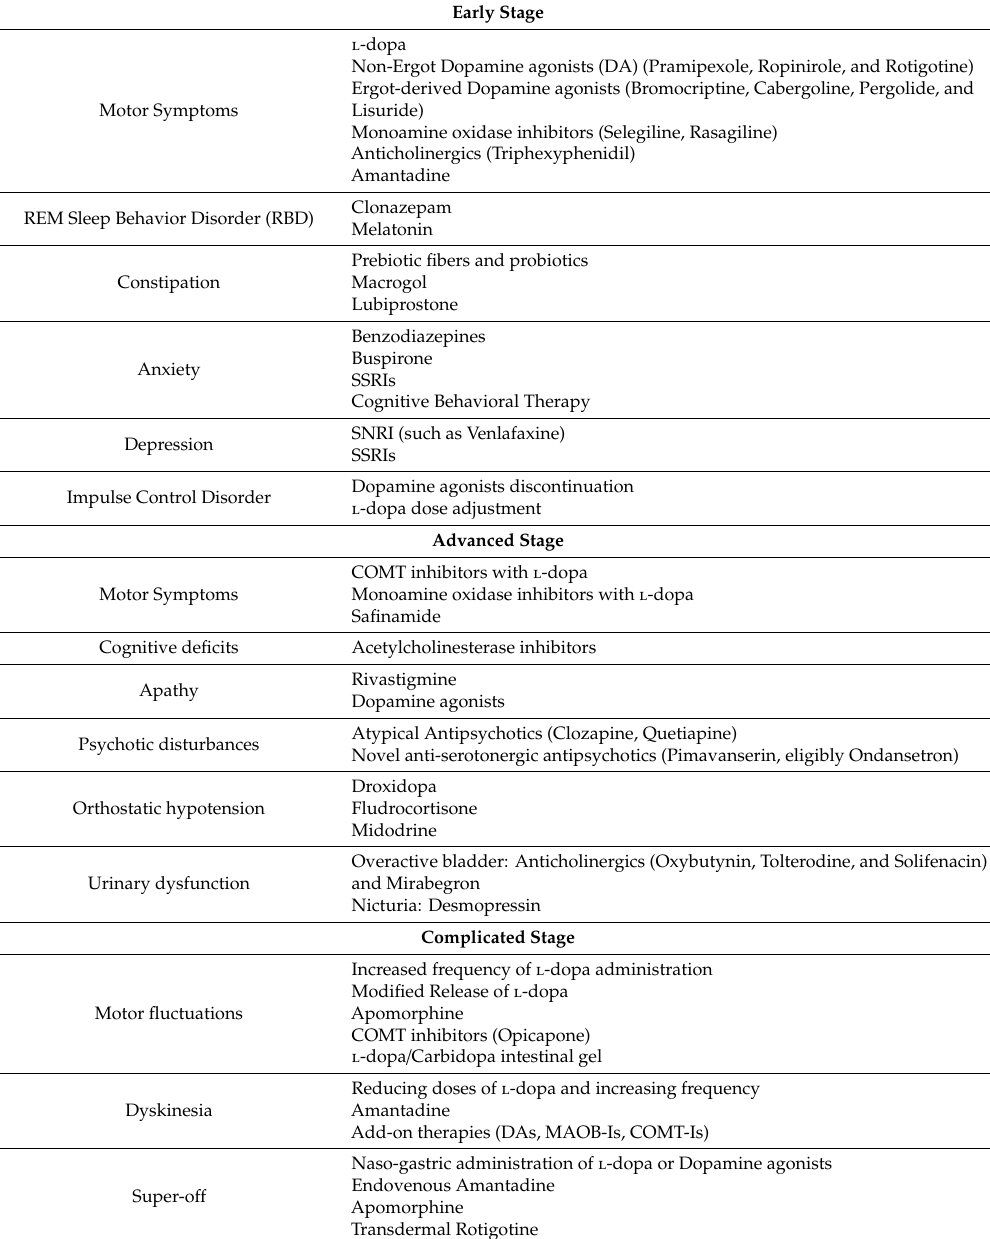
Table 1. Main pharmacological treatments for motor and non-motor symptoms in each clinical stage of Parkinson’s Disease